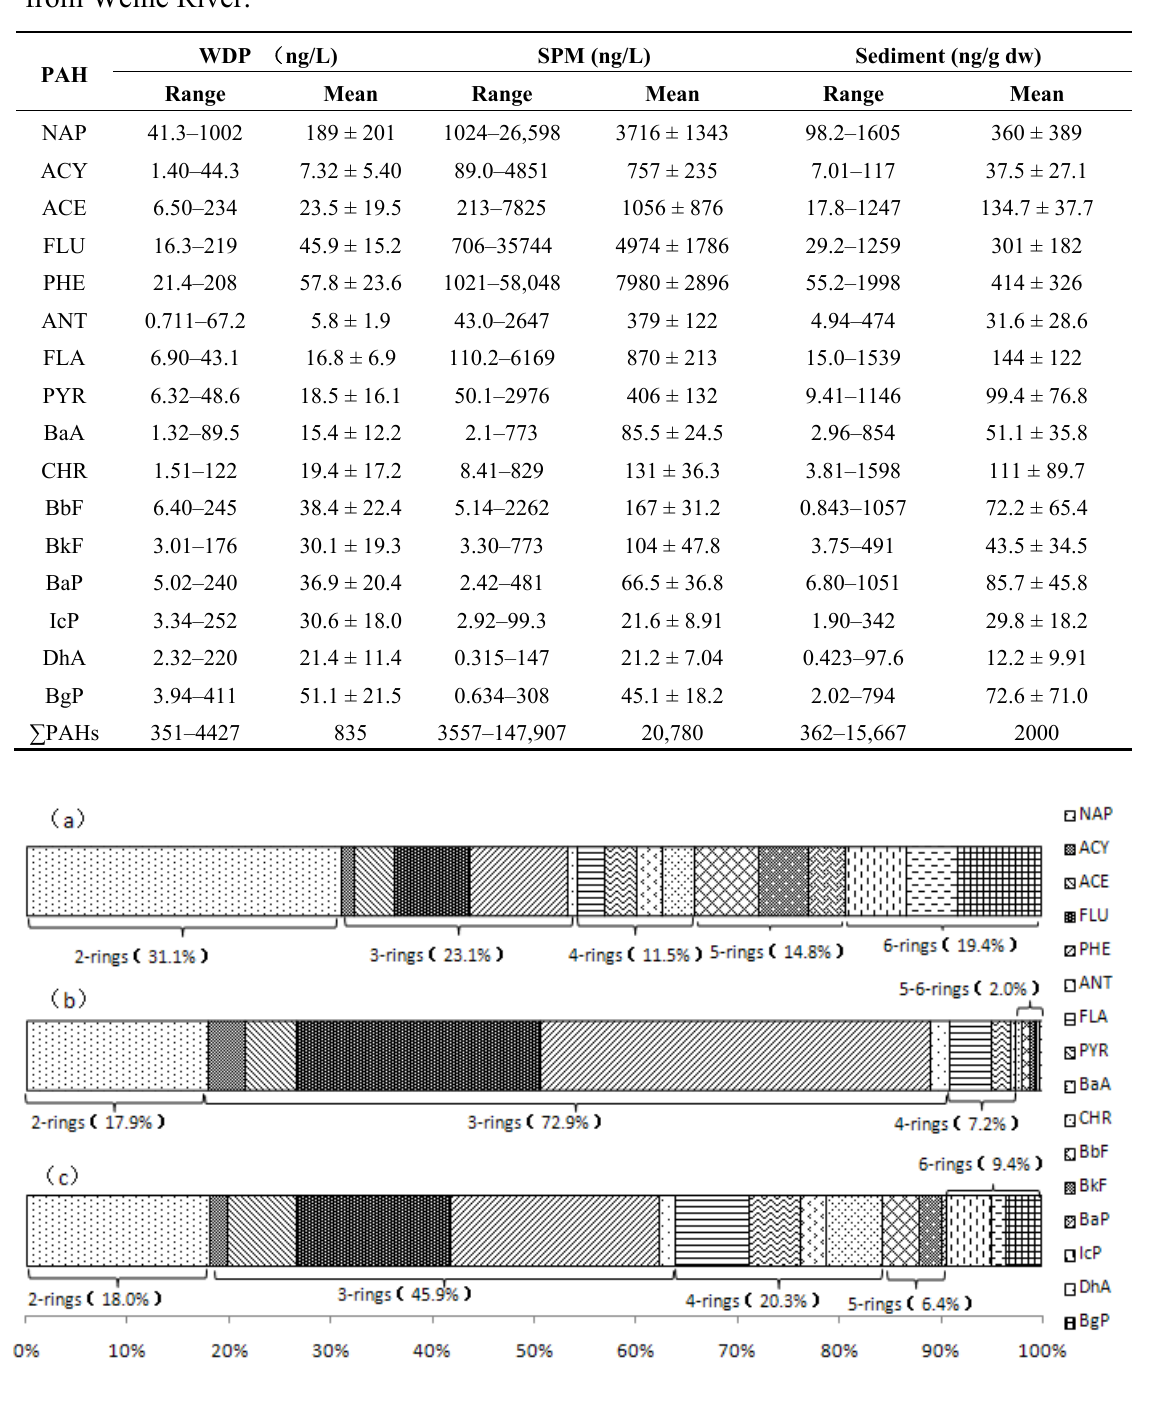
Figure 2. Mean concentration of individual PAHs in ( a ) WDP, ( b ) SPM and ( c ) sediment. Compared with other polluted rivers in the world (Table 2), the mean concentrations of ∑ PAHs in WDP from Weihe River were much higher than those found in Jinjiang River in China (53.2 ng/L) by Yang et al. [11], in the Susquehanna River in USA (67 ng/L) by Ko et al. [14], in the Yellow River Delta in China (121 ng/L) by Wang et al. [13] and in Henan Reach of Yellow River in China (662 ng/L)